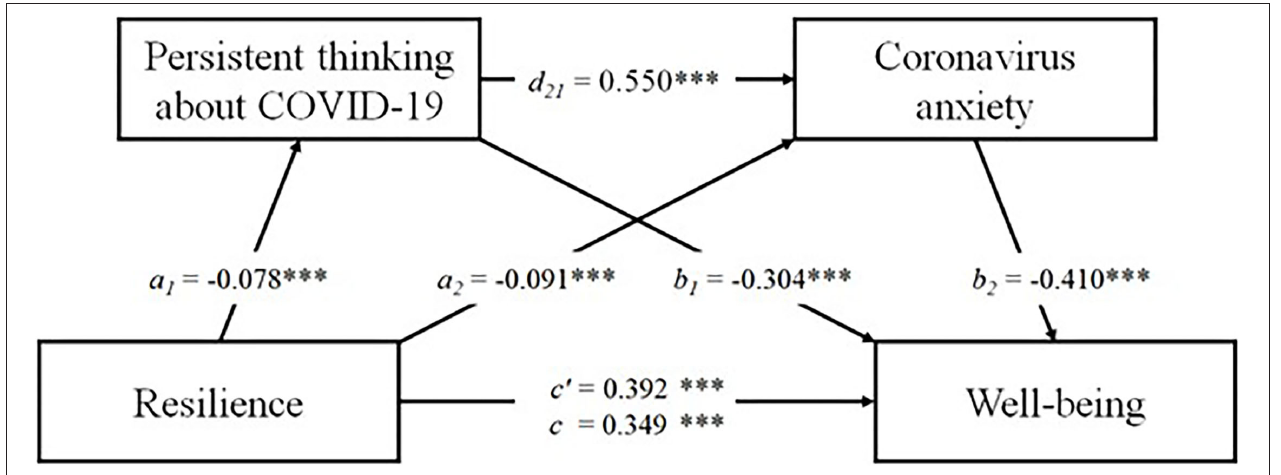
FIGURE 1 | The result of serial multiple mediational model, *** p < 0.001. Values shown are unstandardized